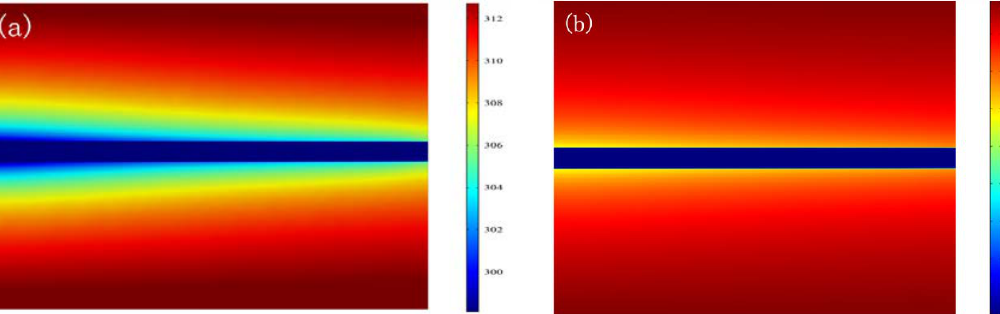
Figure 9. Comparison of thermal insulation effect of supporting materials (longitudinal section): ( a ) cloud map of the temperature field of the concrete support roadway; ( b ) cloud diagram of temperature field of test specimen XX45 insulation support roadway. Figure 10. Temperature isosurface: ( a ) temperature isosurface of concrete support roadway; ( b ) temperature isosurface of roadway supported by test specimen XX45 insulation material. From each type of support material, the thermal conditions on the model outer boundary are the same, and the temperature of the airflow is the lowest at the air inlet. From Figure 8a, the temperature of the surrounding rocks shows a clear gradual trend. Due to the higher thermal conductivity of the